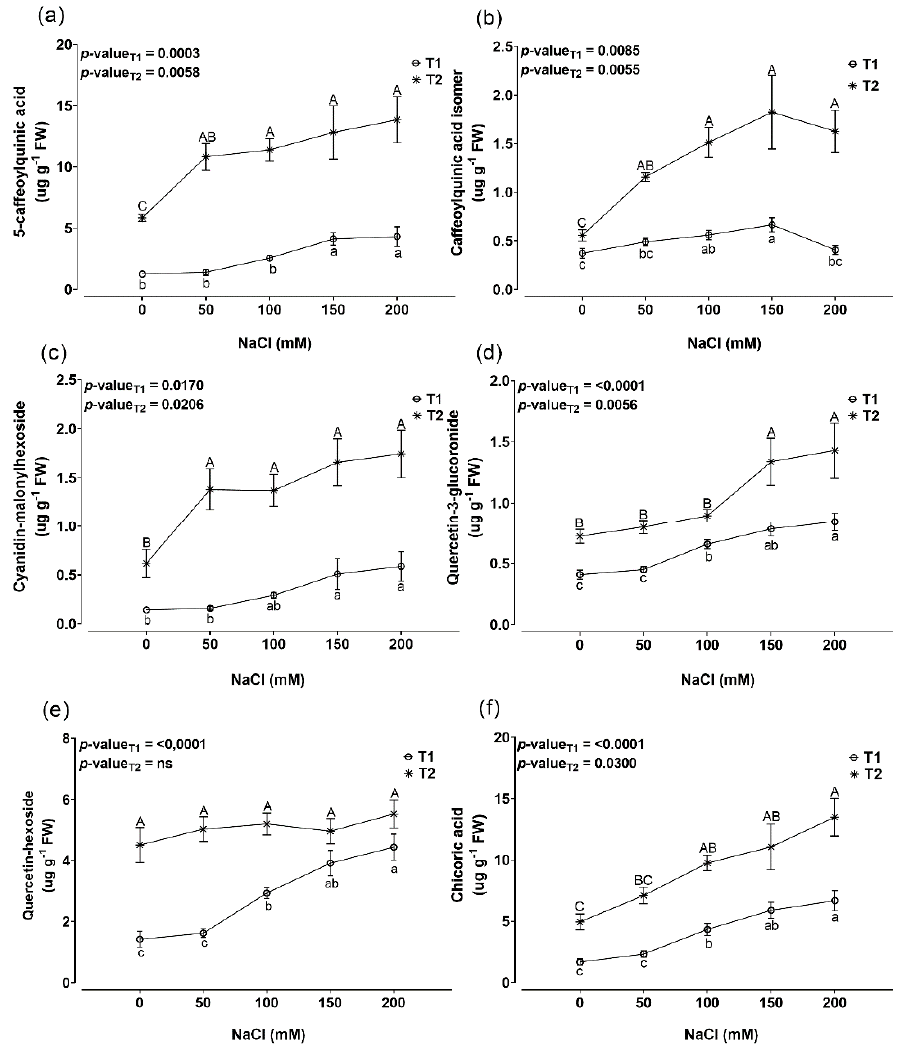
Figure 5. Concentration of 5-caffeoylquinic acid ( a ), caffeoylquinic acid isomer ( b ), cyanidin- malonylhexoside ( c ), quercetin-3-glucoronide ( d ), quercetin-hexoside ( e ), and chicoric acid ( f ) in red lettuce plants ( Lactuca sativa Lollo Rosso cv. ´CARMOLI´) growing at different saline concentrations in a hydroponic system. T1: concentrations after 7 days of NaCl application. T2: concentrations after 15 days of NaCl application. Different letters indicate significant differences ( p < 0.05), according to the Tukey multiple range test ( p < 0.05) following ANOVA. Data are expressed as mean ± SE, n = 6.